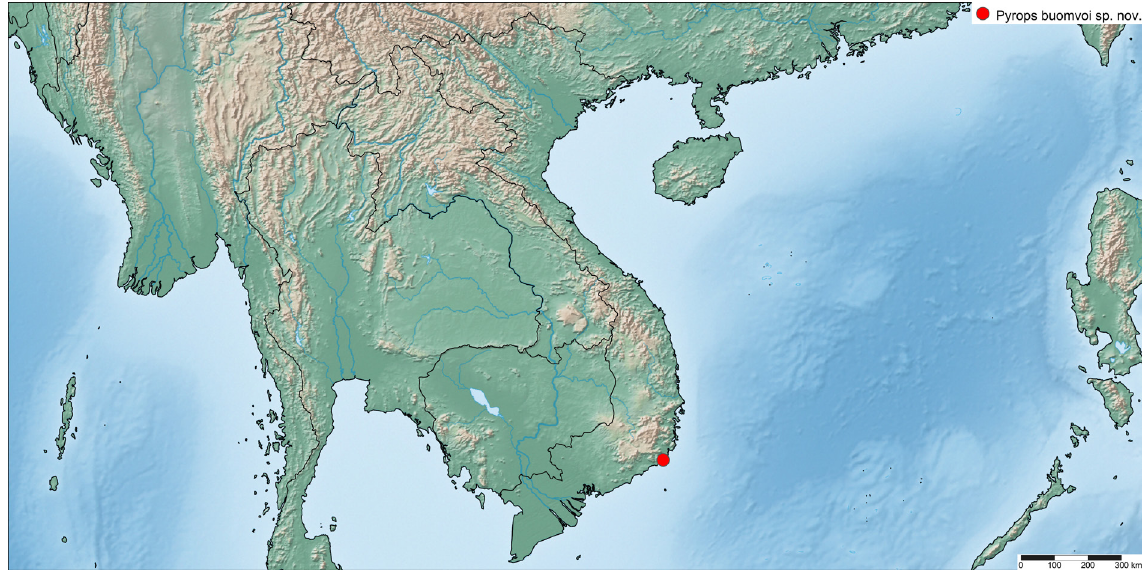
Fig. 3. Pyrops buomvoi sp. nov., distribution